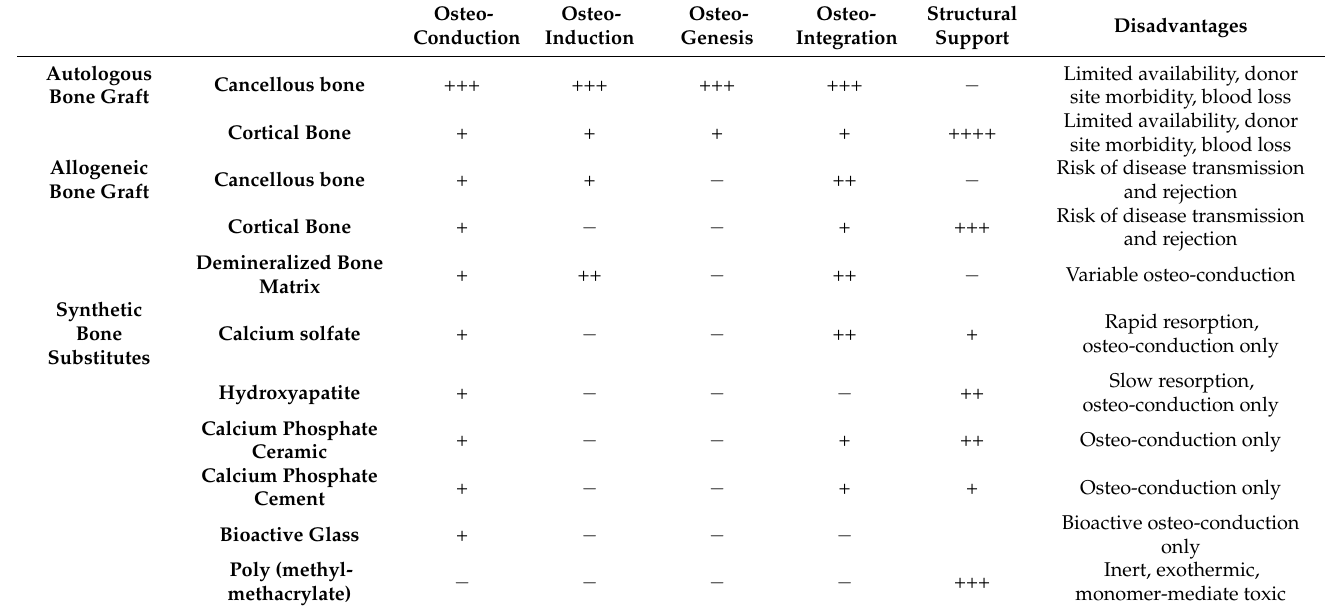
Table 2. Characteristics of the main bone grafts and substitutes in clinical application. Table published under permission of Bhatt R.A et al., 2012 and Greenwald A.S. et al., 2001 [37,38] through Copyright Clearance Center’s